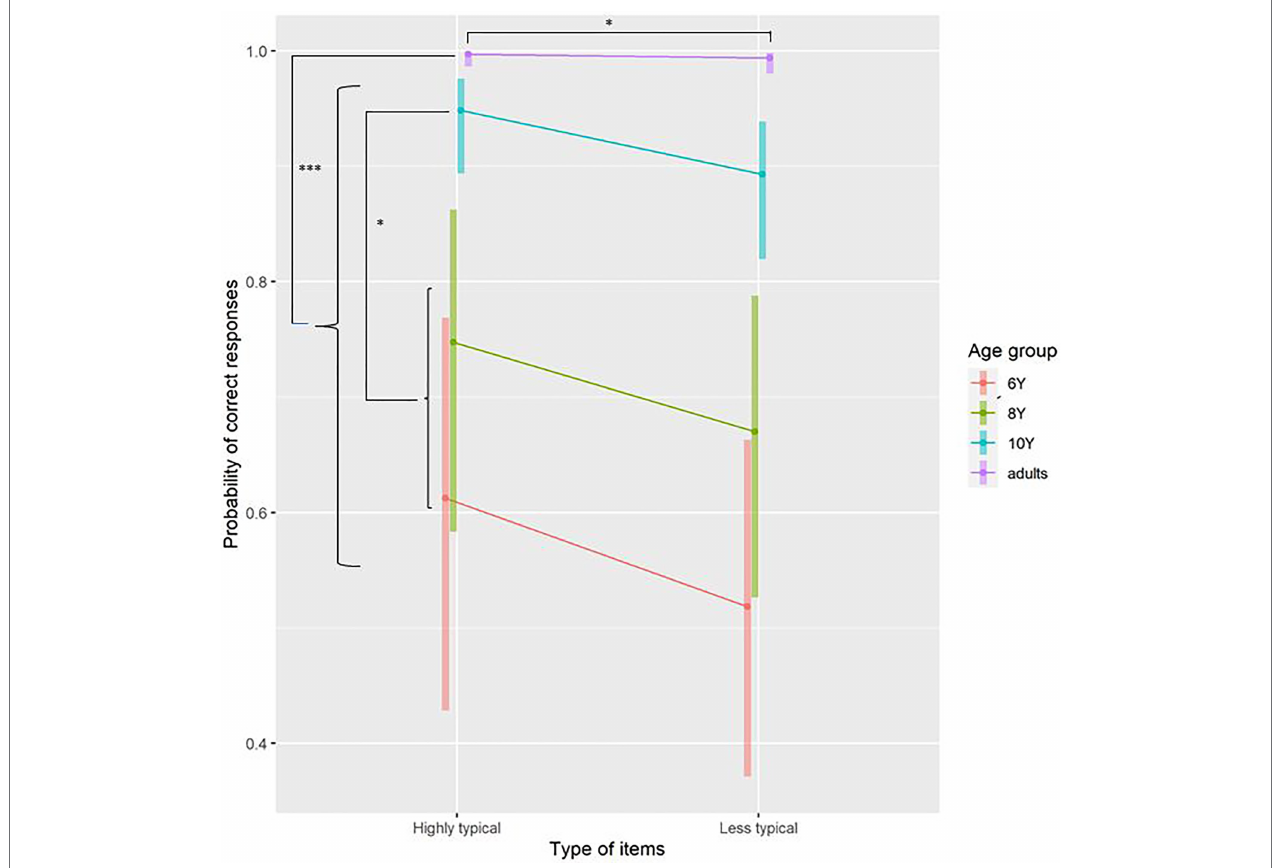
FIGURE 1 | Probability of correct responses in Experiment 1 plotted separately for Age group and Type of item. Error bars are 95% CI. * p < 0.05 and *** p <